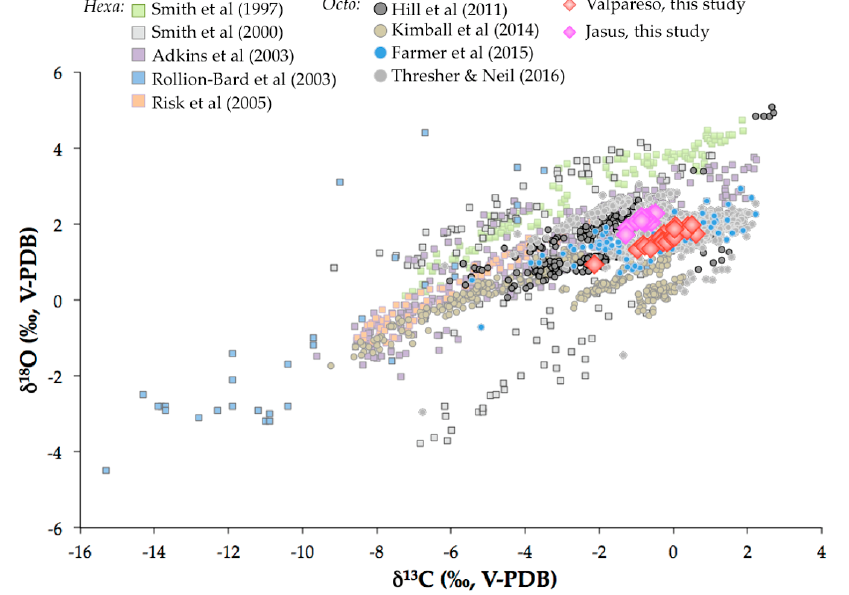
Figure 6. Comparison of the δ 18 O and δ 13 C measurements expressed in per mil (V-PDB) in Valpareso (red diamonds) and Jasus (pink diamonds) samples with data from the literature. Square symbols represent the data for scleractinian corals (data from [7,9,25,48,59]); circle symbols are for octocorallian corals (data from [22,54–56]).